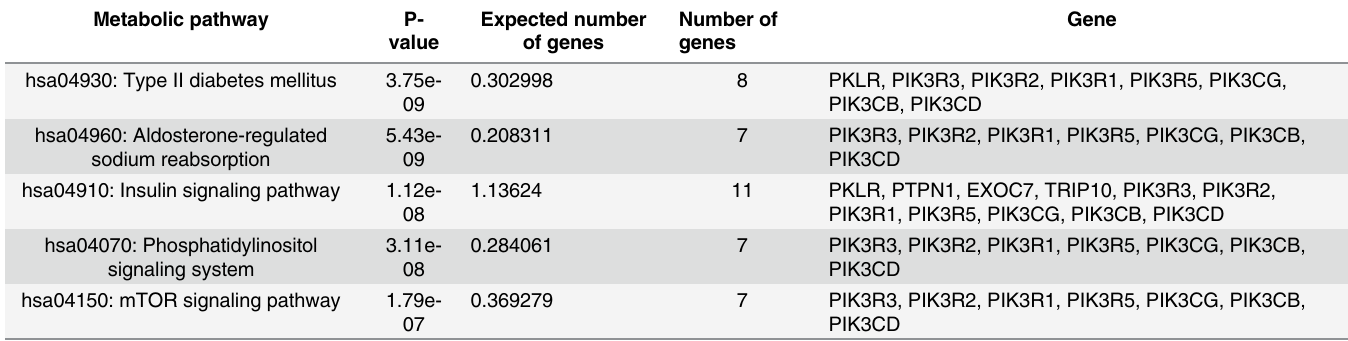
Table 5. Enrichment analysis of causal genes in Diabetes Mellitus, Type 2. Metabolic pathway